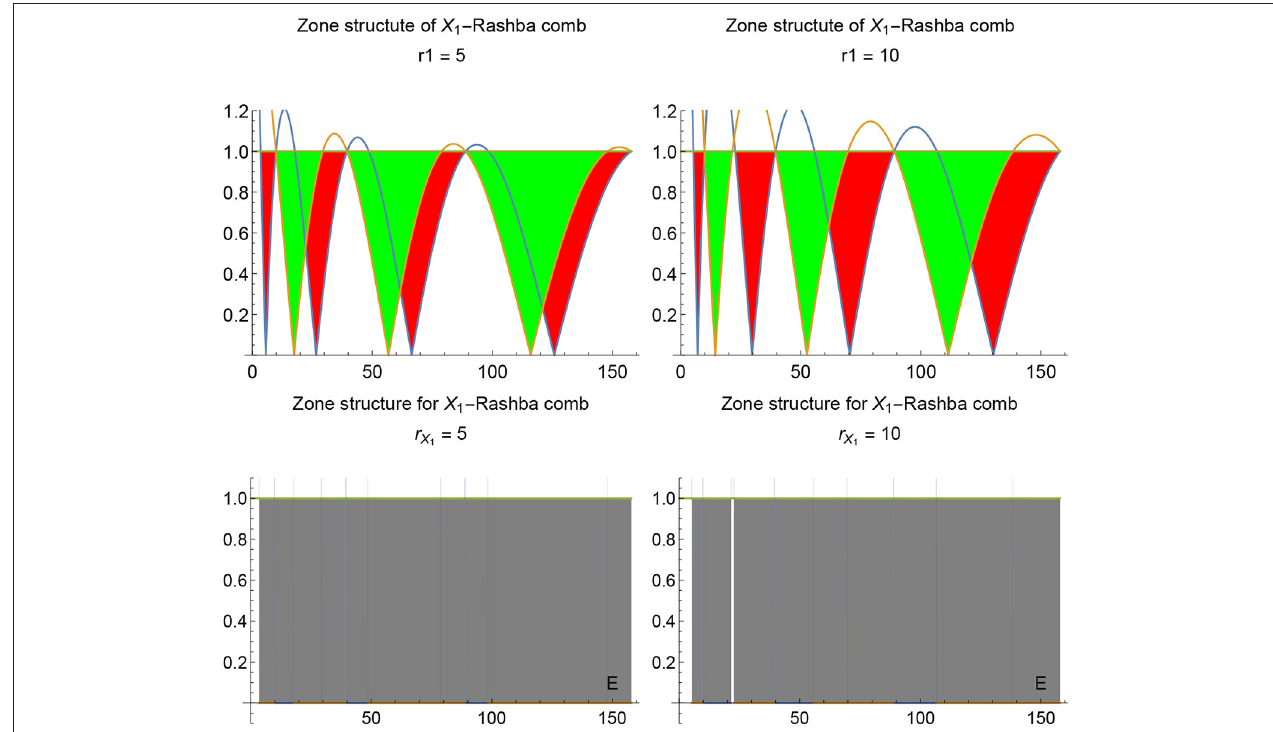
X 1 - comb. Red and green are for “minus” and “plus” branches in Eq. (26) correspondingly. FIGURE 9 | Zone structure of r −